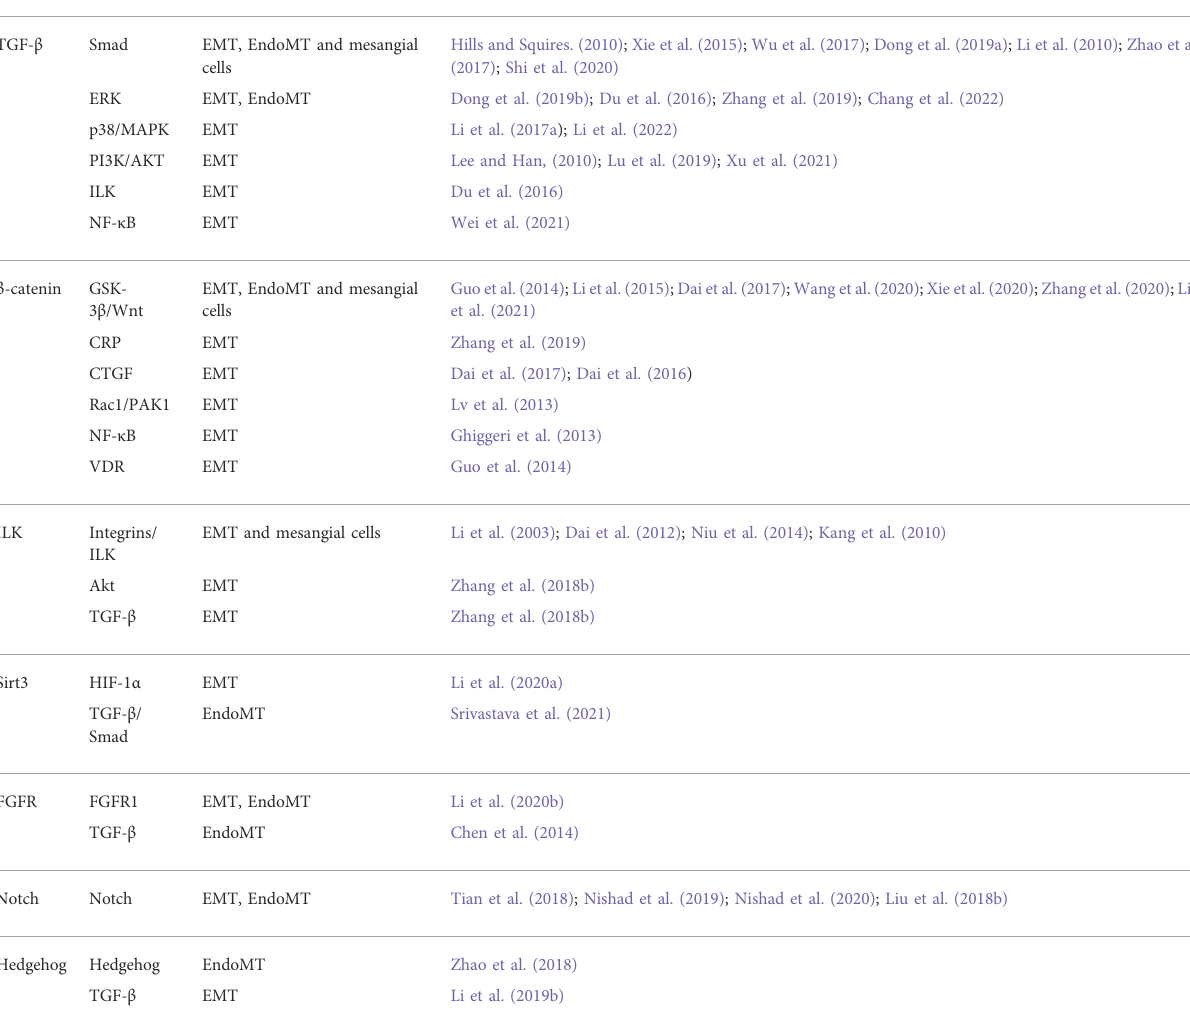
TABLE 1 The major signaling pathways involved in phenotypic transitions in